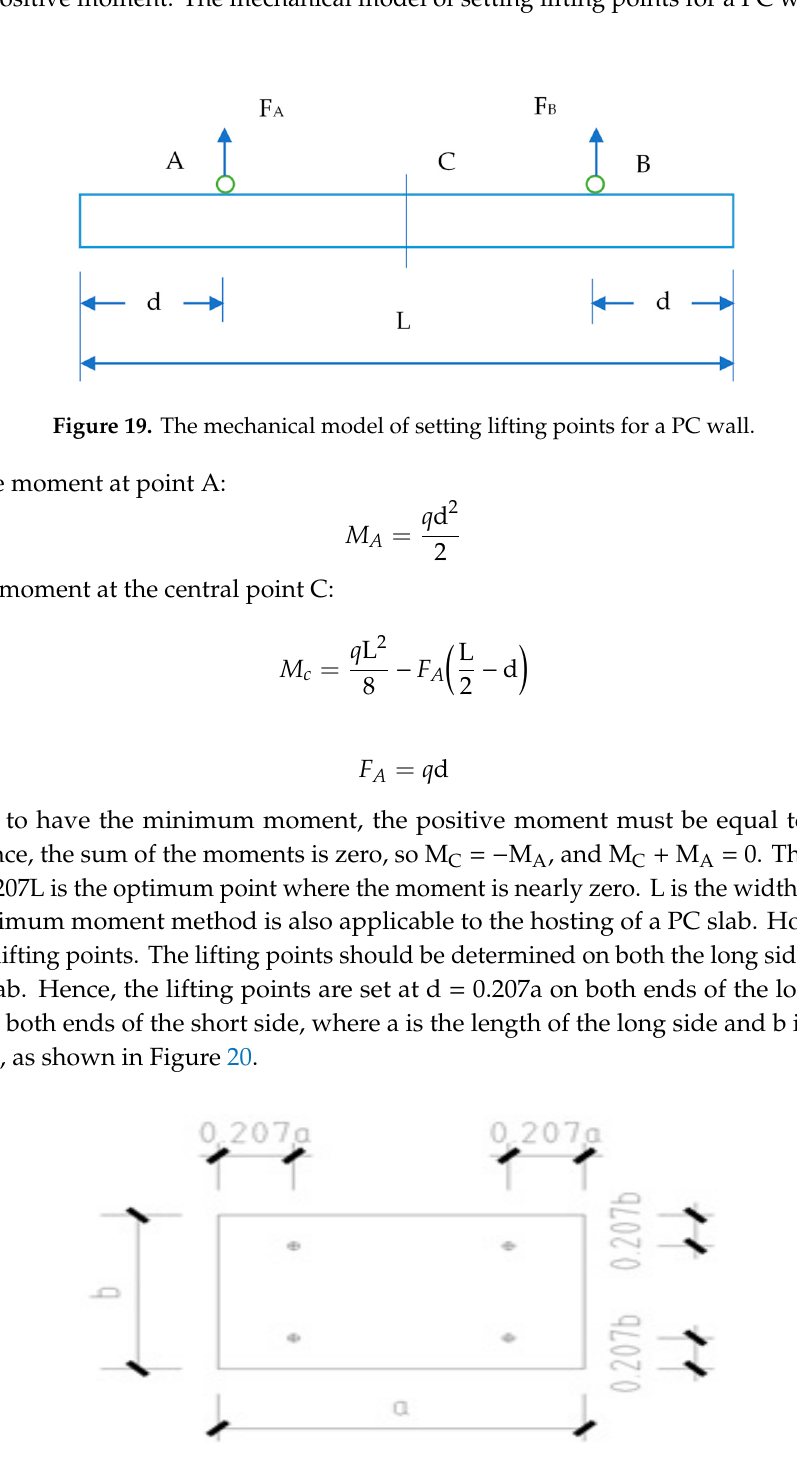
Figure 20. The lifting points of a PC slab.